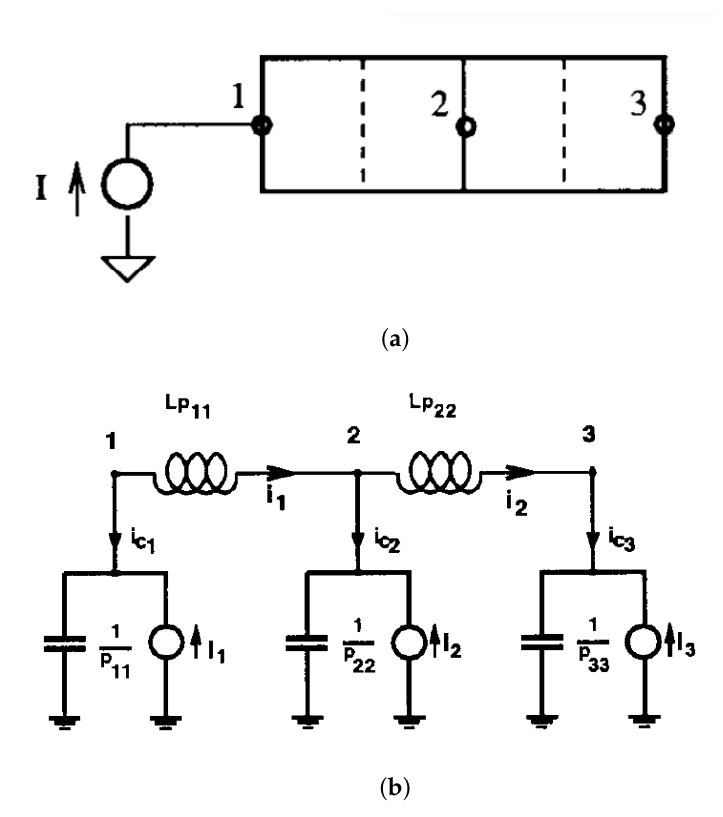
Figure 1. ( a ) Metal strip with two L p cells and ( b ) PEEC model for the metal strip. Choose the parameters Γ = I , c 1 = 1, c 2 = 2, T = 10 and γ = 0.2. By using